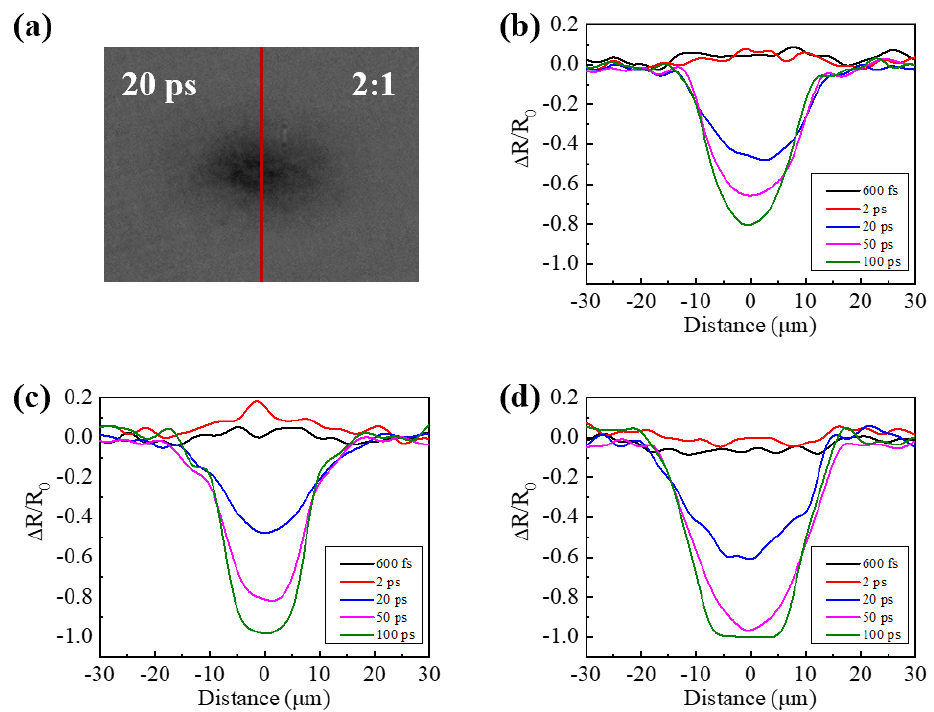
Figure 3. ( a ) The extracted curve of the spatial reflectivity distributions in Figure 2b3 for an example, ( b ) Spatial reflectivity distribution of the pure GST films extracted from the short axis of the focal area in Figure 2a1 – a5, ( c ) Spatial reflectivity distribution of 2:1 films extracted from the short axis of the focal area in Figure 2b1 – b5, and ( d ) Spatial reflectivity distribution of 2:2 films extracted from the short axis of the focal area in Figure 2c1 – c5.